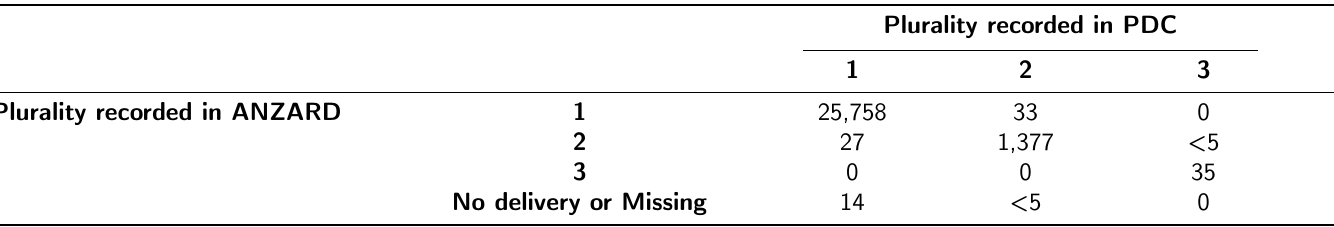
Plurality recorded in